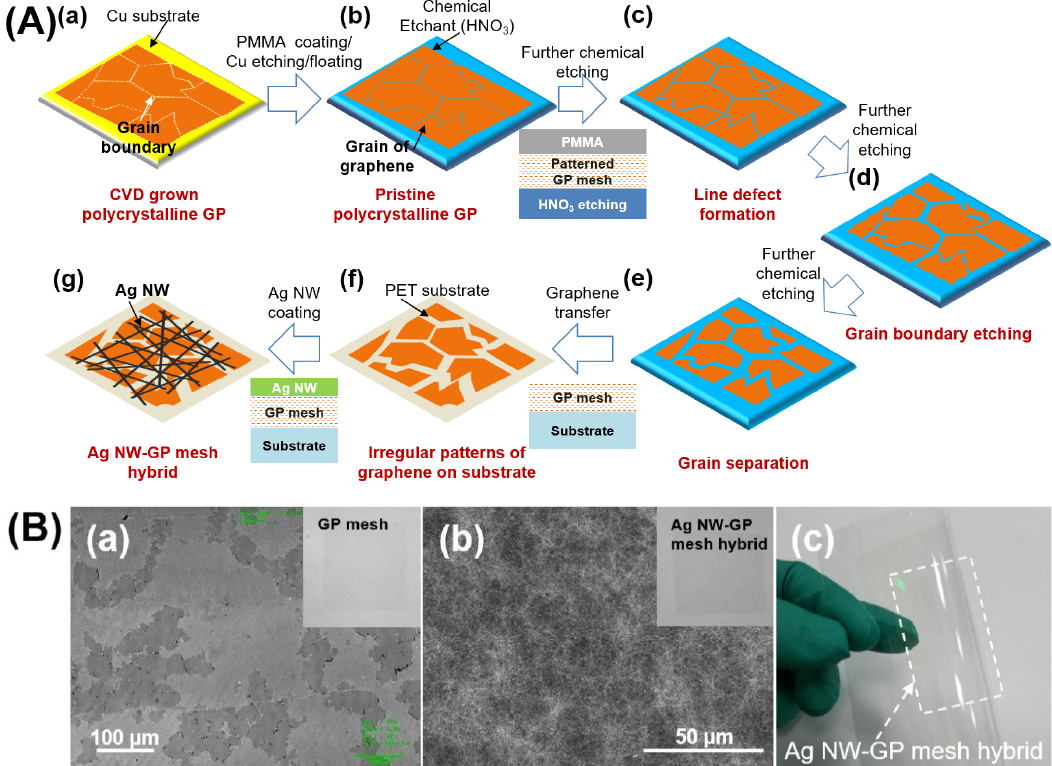
Figure 1. ( A ) schematic illustration for preparation of irregularly patterned GP mesh and its hybrid with Ag NWs (Ag NW-GP mesh hybrid). ( a ) polycrystalline GP prepared by chemical vapor deposition method, ( b ) PMMA coated pristine polycrystalline GP floated on chemical etchant, ( c ) formation of line defect by chemical etchant on the GP, ( d ) more line defects formation leading to the etched grain boundary of GP, ( e ) formation of irregularly patterned GP mesh of separated GP grains, ( f ) as-formed irregularly patterned GP mesh transferred on substrate, ( g ) hybrid conductor film of Ag NW and patterned GP mesh; ( B ) morphology of conductors: ( a ) optical image of irregularly patterned GP mesh (HNO 3 ) by OM, ( b ) electron image of an Ag NW hybrid with irregularly patterned GP mesh (HNO 3 ) by SEM, ( c ) digital-photo image of transparent conductive film of Ag NW-GP mesh hybrid.